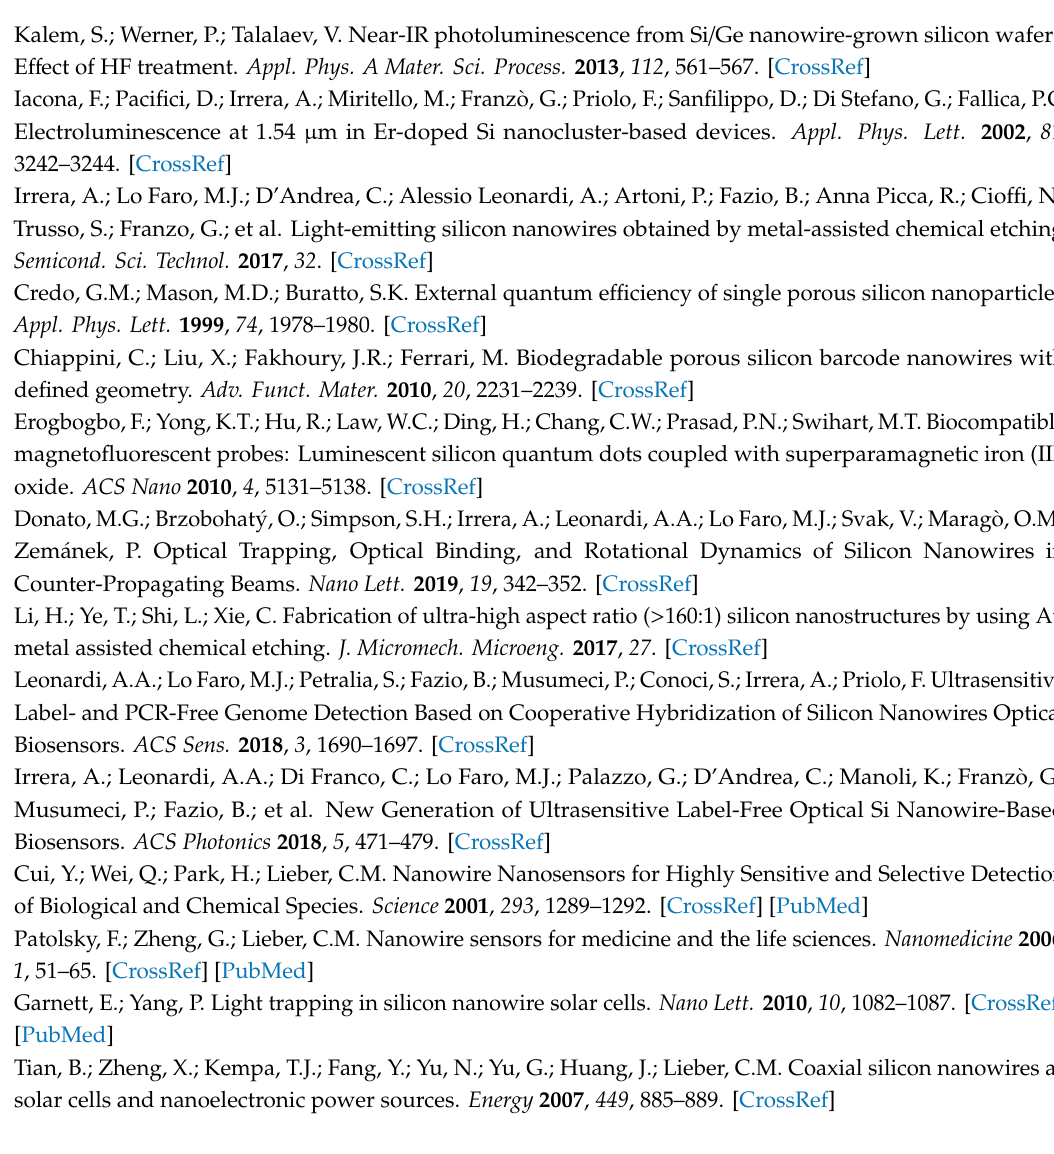
Figure S1: SEM image at high magnification of Sample A, Figure S2: SEM image at high magnification of Sample B, Figure S3: CV of Cd2 + solution on Se deposit and CV of Se(IV) solution on Cd